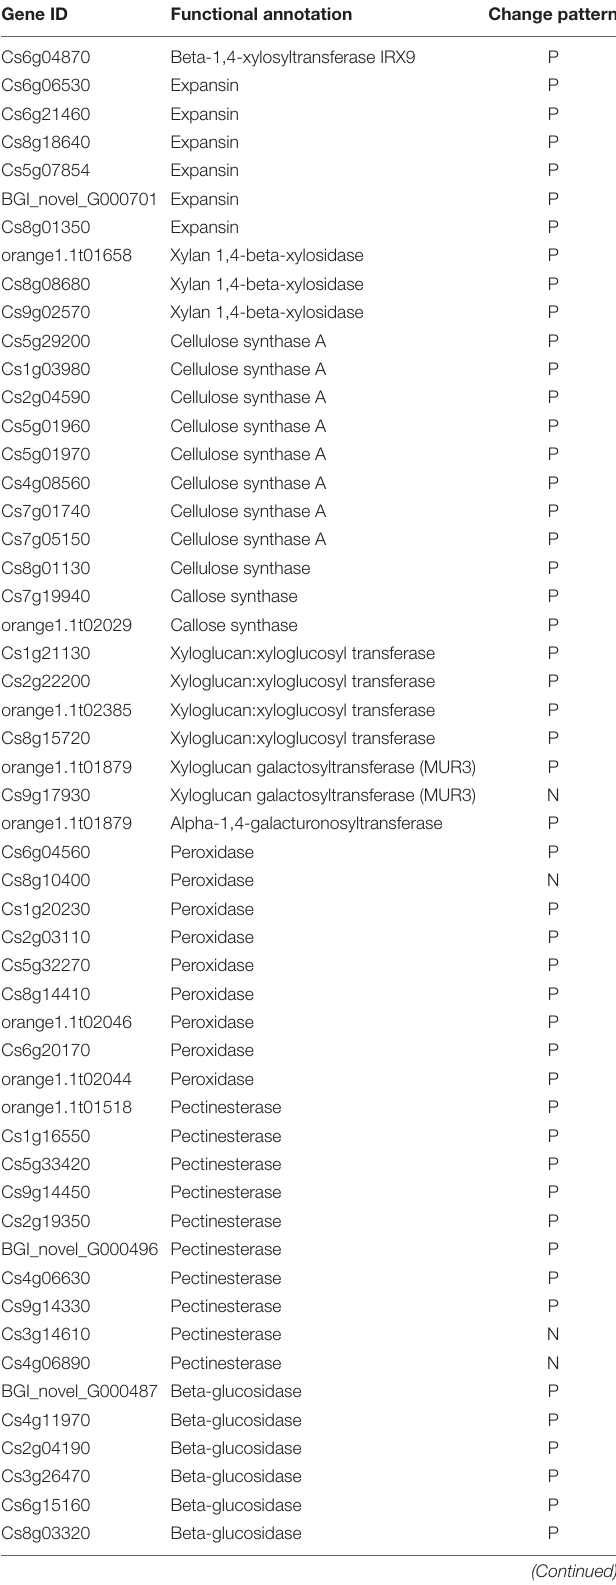
TABLE 2 | Selected DEGs related to the cell wall